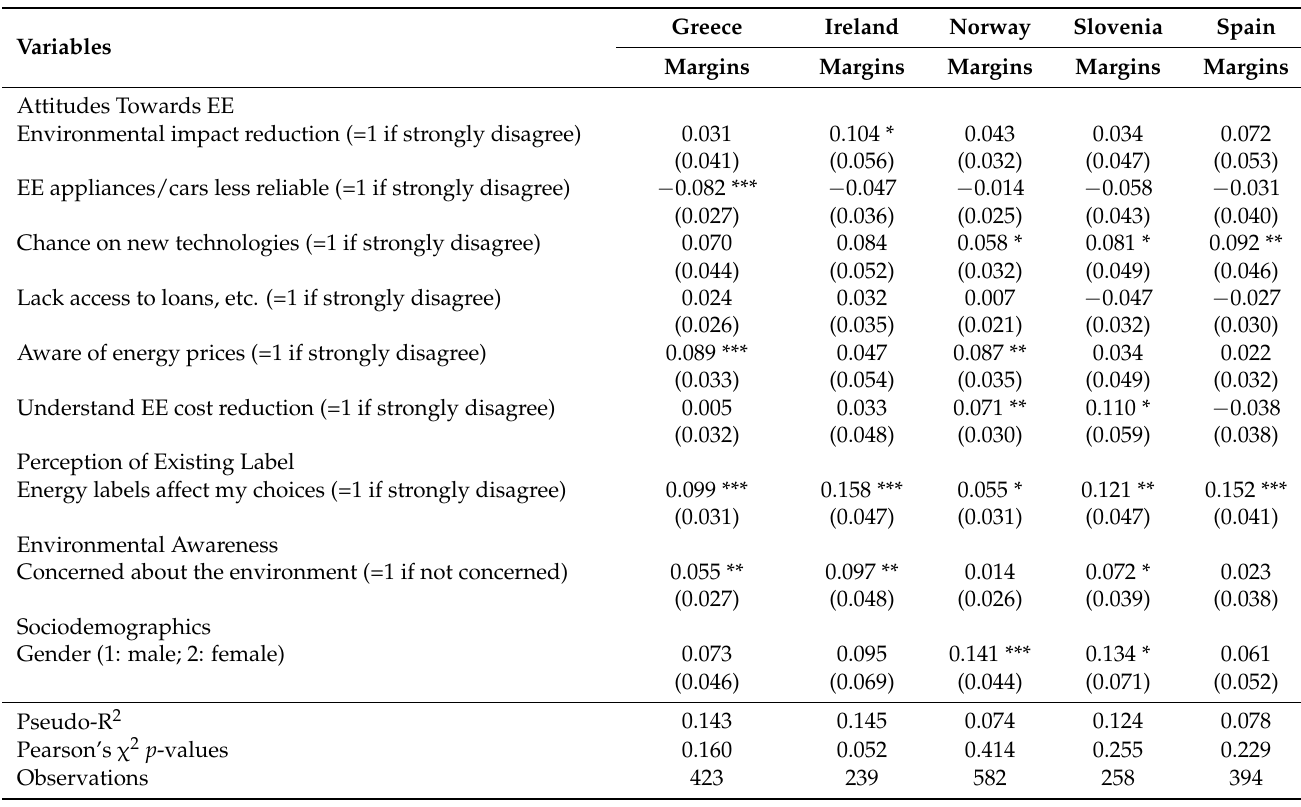
Table 3. Variables affecting households’ perceptions of energy efficiency—probit marginal effects (country subsamples).